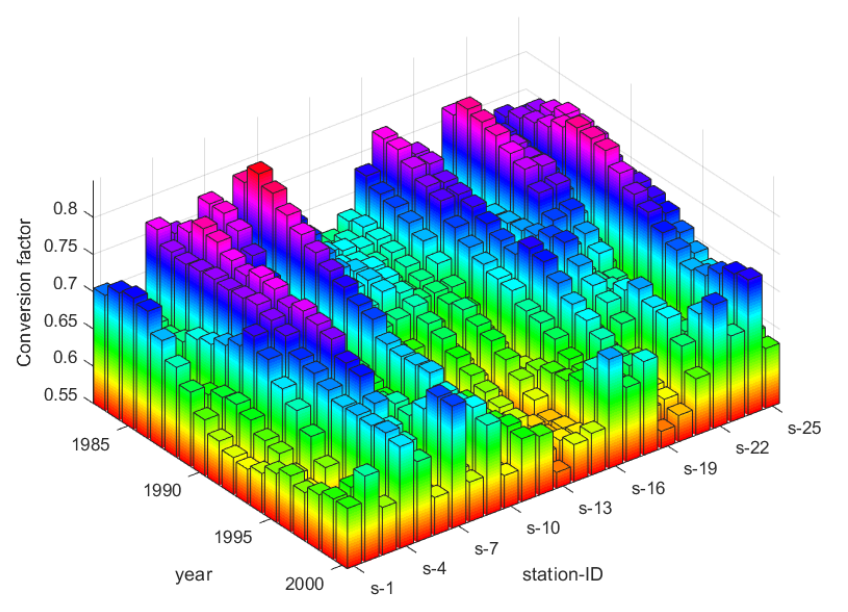
Figure 12. Matrix of conversion coefficients for two pans for the third cycle (series length of 6